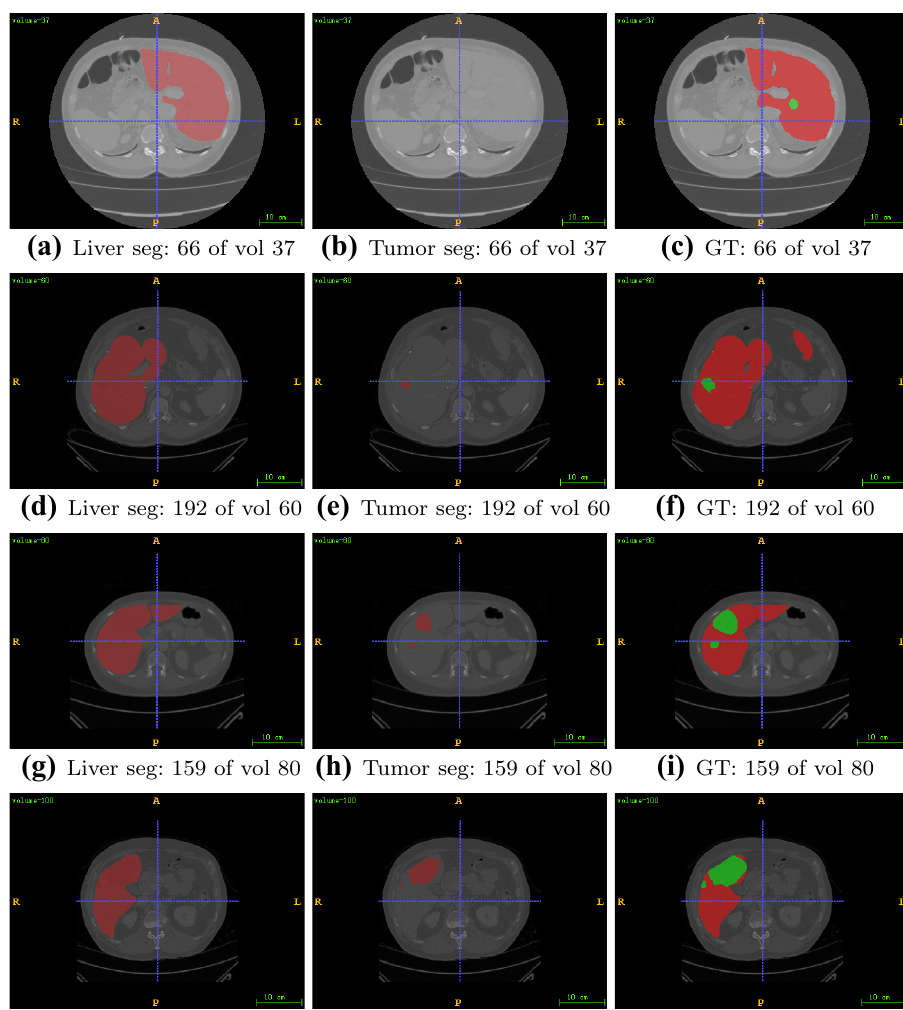
Fig. 4 Semantic segmenta- tion samples extracted from transverse sections from LiTS challenge by our method. Images in the first and second columns with light red masks indicate segmentation results of liver and tumor, respectively. The segmentation with deep red color in the third column is the ground truth informa- tion provided by LiTS dataset. The slice and volume number of capture is denoted in cap- tions of each subfigure. The image and segmentation are displayed by iTK-SNAP